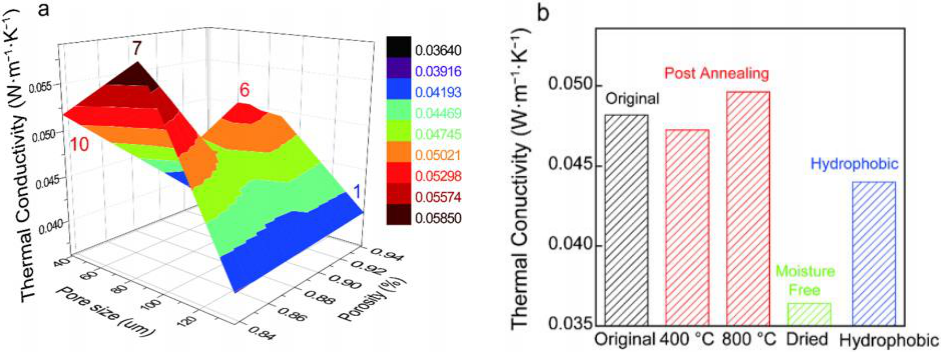
Figure 17. ( a ) Thermal conductivities of the series of PGA foams dependent on average pore size and porosity. ( b ) Thermal conductivity corresponding to different post annealing temperature and thermal conductivity before and after hydrophobicity treatment (Reprinted with permission from Ref. [89]. 2020 American Chemical Society).